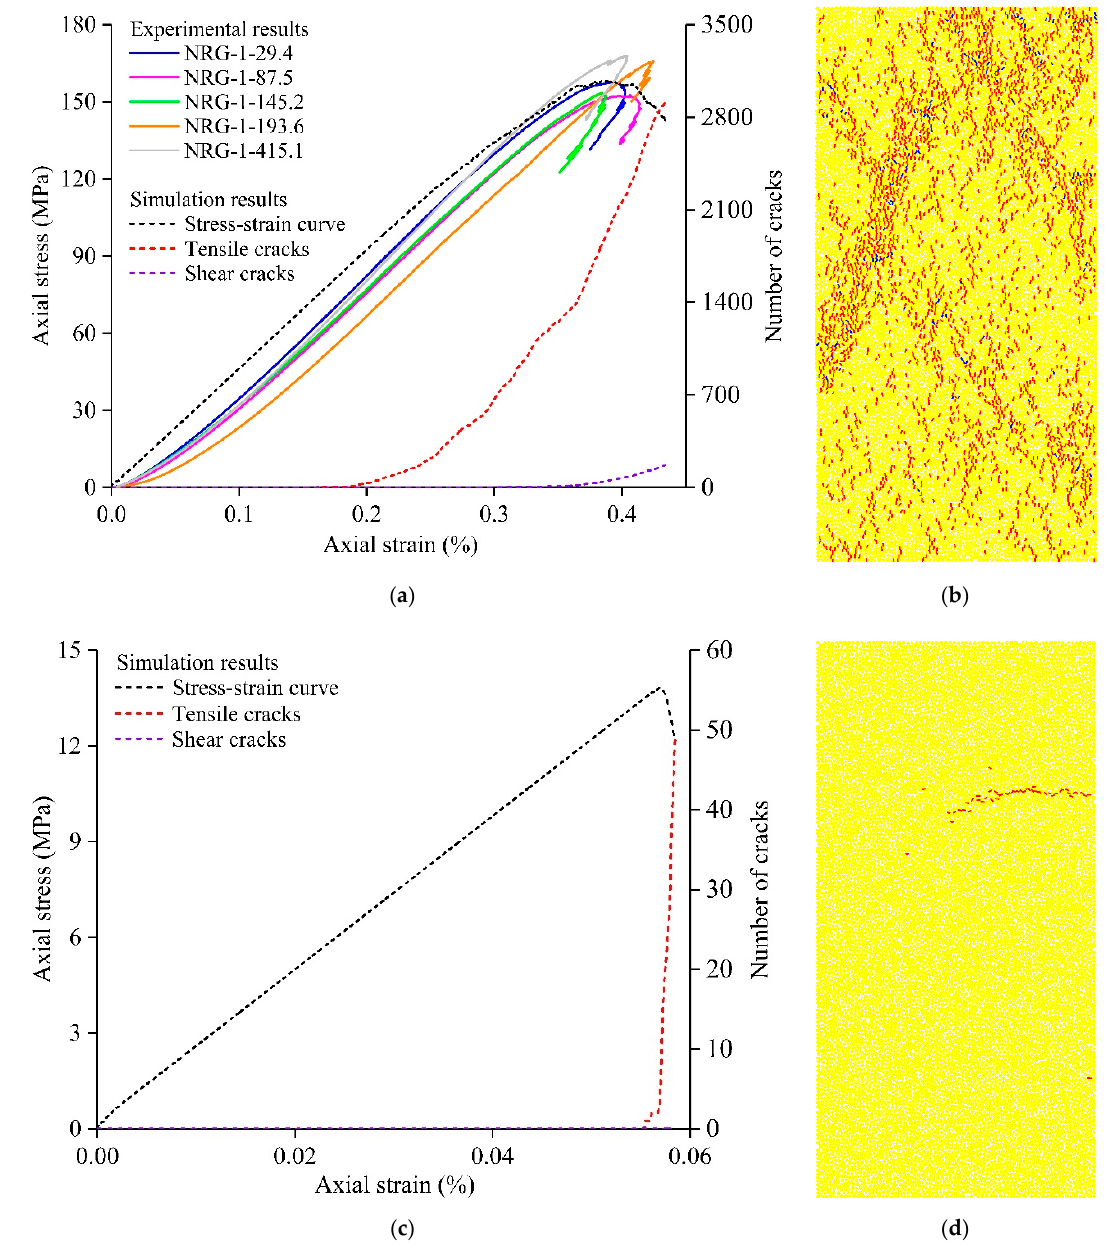
Figure 4. The simulated results under the calibrated parametric condition: ( a ) stress-strain curve and microcrack evolution under uniaxial compression; ( b ) microcrack distribution after uniaxial compression; ( c ) stress-strain curve and microcrack evolution under uniaxial tension; and ( d ) microcrack distribution after uniaxial tension.